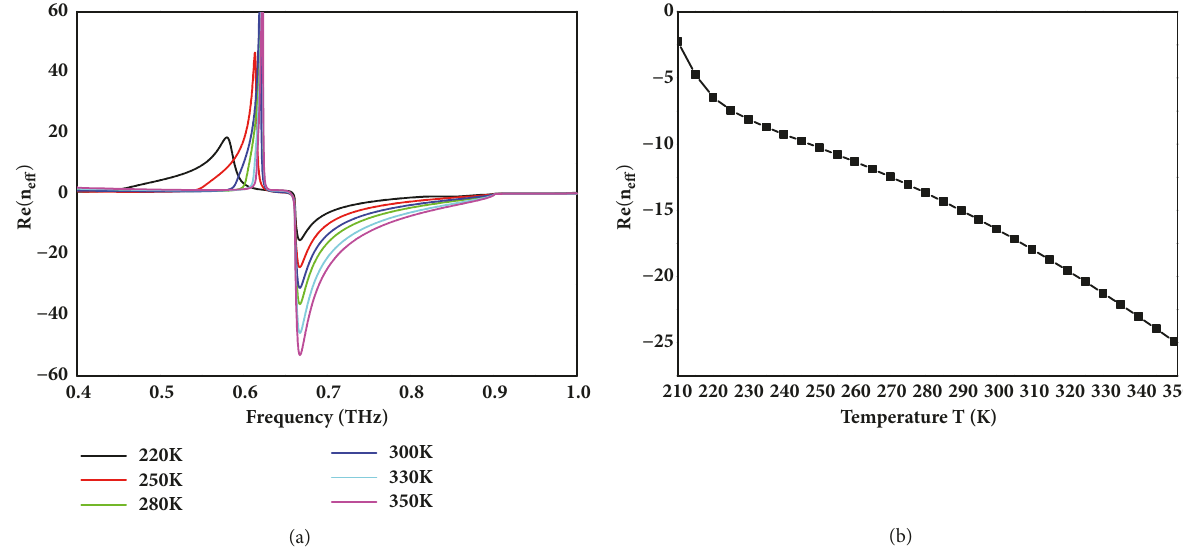
Figure 3: The thermotunable negative-index metamaterials. (a) The real part of the refractive-index 𝑛 𝑒𝑓𝑓 at different temperatures ranging from 220 to 350K. (b) The real part of the refractive-index 𝑛 𝑒𝑓𝑓 at 𝜔/2𝜋 = 0.7 THz for different temperatures ranging from 210 to